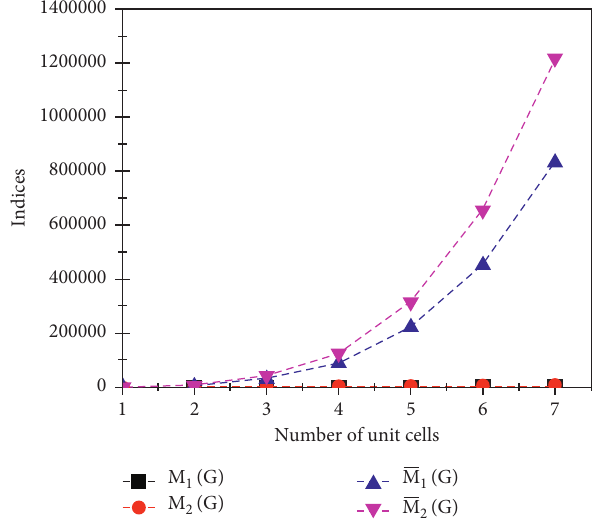
Figure 5: Comparison of M